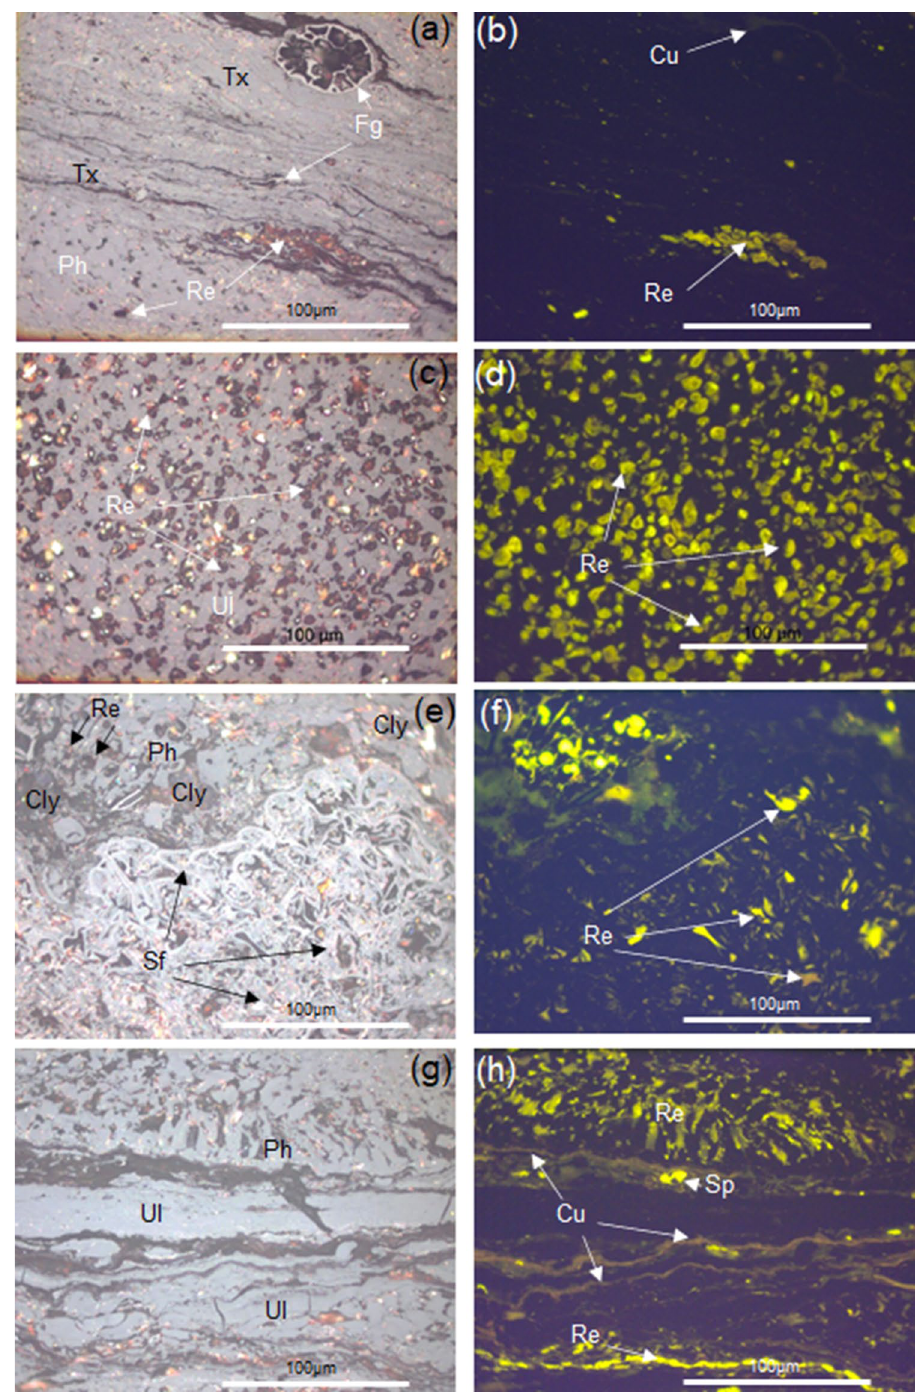
Figure 3. Photomicrographs of organic matter assemblages from the studied Mukah coals in the Balingian Formation; under white light (left) and reflected light (right): ( a – h ) resinite (Re), cutinite (Cu), sporinite (Sp), semifusinite (Sf), and funginite (Fg) associated with huminite macerals of textinite (Tx), ulminite (Ul) and phlobaphinite (Ph) as a dominant maceral group assemblage. Clay (Cly) matrix can be observed in ( e , f